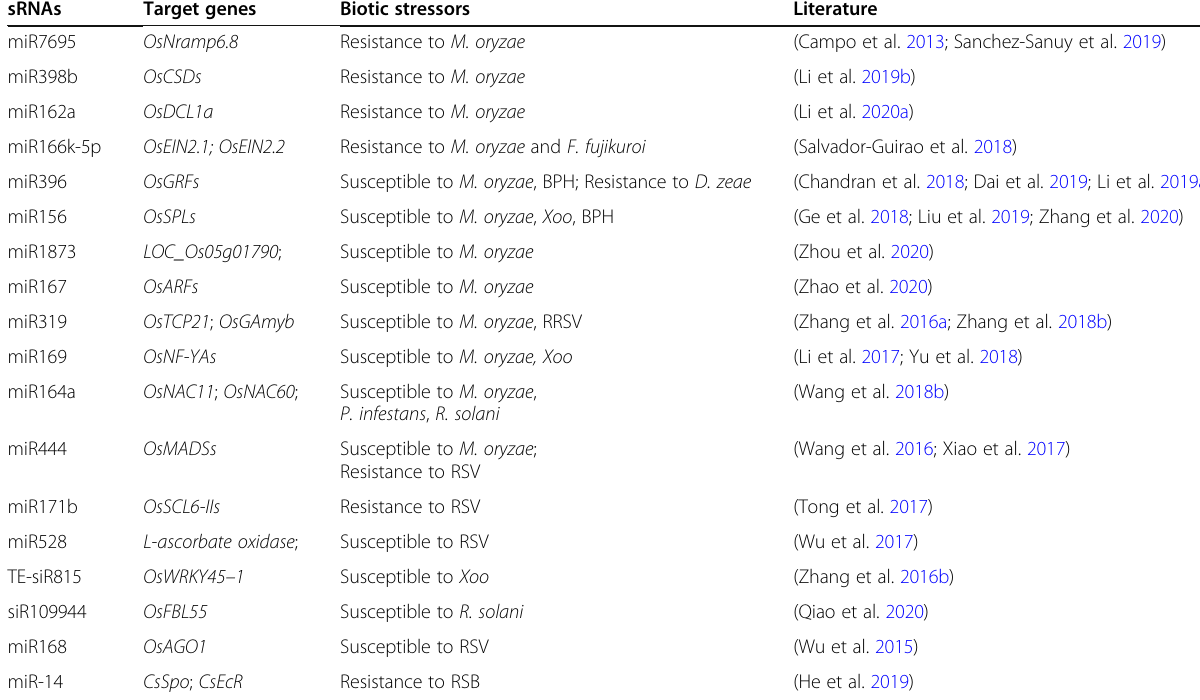
Table 1 Characterized sRNAs involved in interactions of rice with pathogens and insect pests sRNAs Target